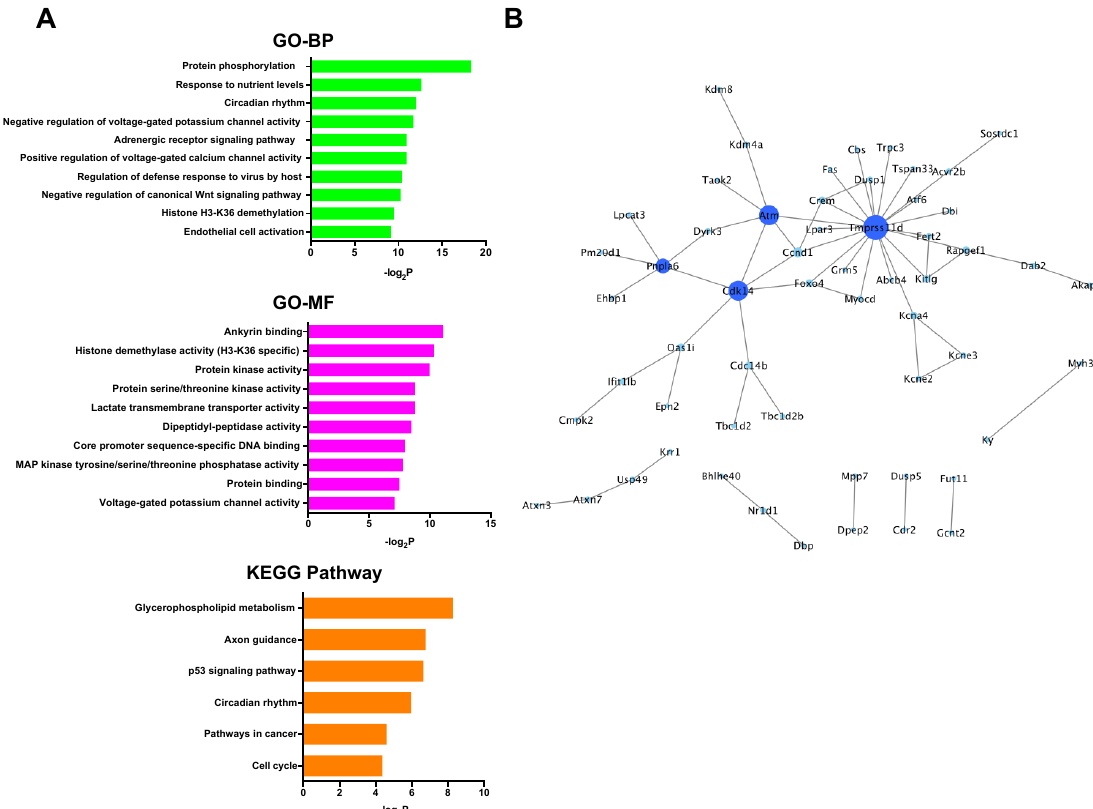
Figure 5. ( A ) GO and KEGG pathway analyses of the down-regulated mRNAs. ( B ) PPI network analysis among the down-regulated mRNAs. Blue color node indicates down-regulation. The size and color depth of nodes represent the number of interactions and the edges represent the relationships between genes. BP: biological process, GO: gene ontology, KEGG: Kyoto Encyclopedia of Genes and Genomes, MF: molecular function, PPI: protein-protein